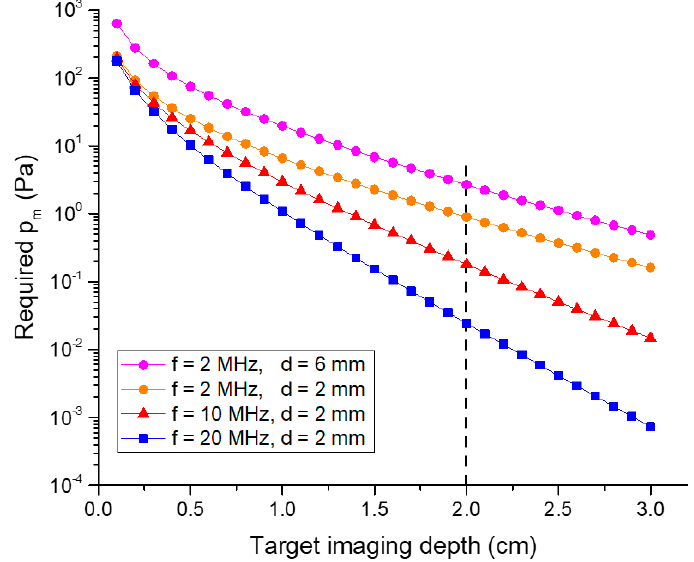
Figure 2. Required minimum detectable pressures of ultrasound transducers for different imaging depths for breast tissue with a 757 nm wavelength (note that this chart will vary with different tissues and/or different light wavelengths).